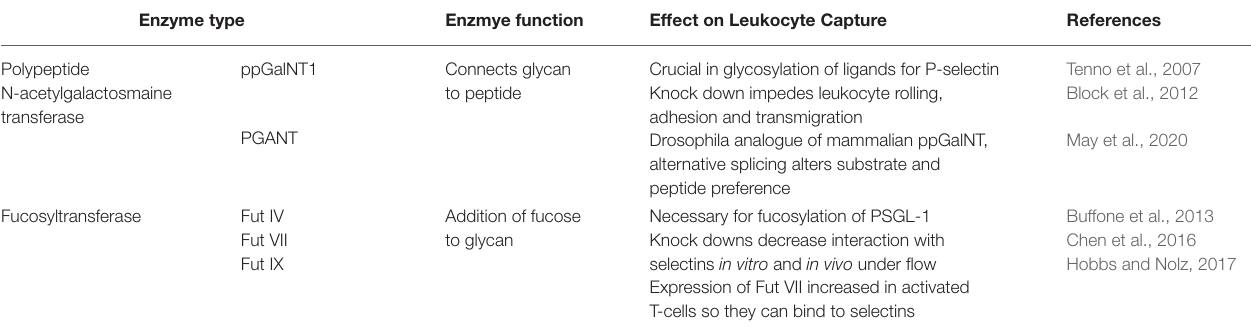
TABLE 1 | Enzymes involved in the capture of